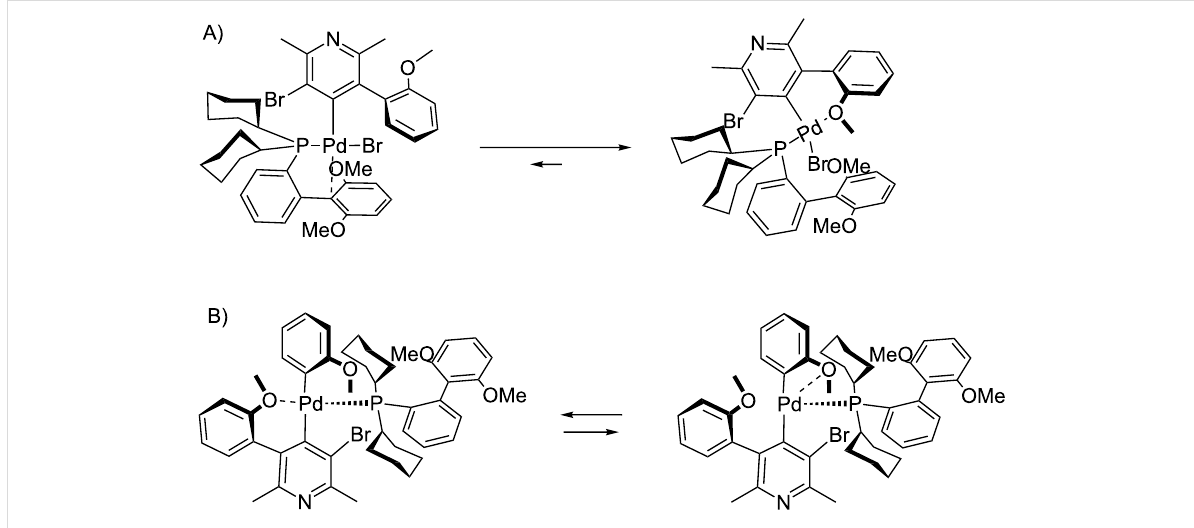
Figure 7: Proposed intermediates for the 1,2-addition of 5 with methoxy group. A) Oxidative addition step. B) Transmetalation